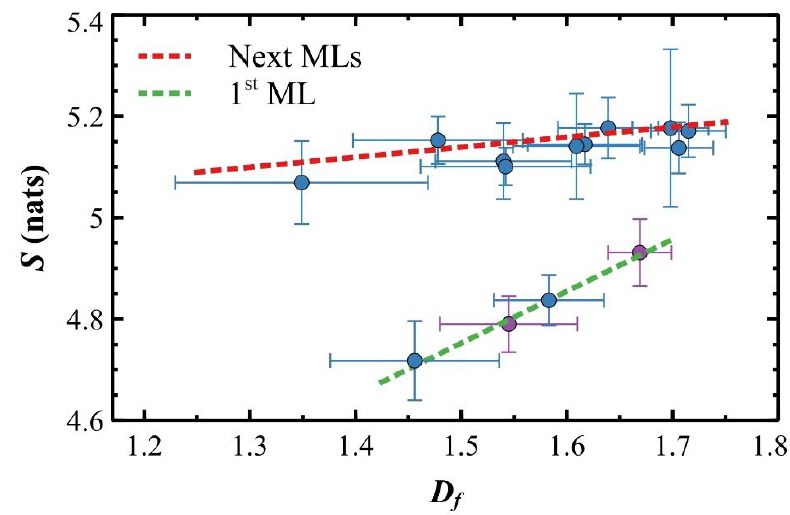
Figure 7. (Averaged) interfacial Shannon entropy S and fractal dimension D f plot with fitted linear correlations. All the data were obtained from the AFM images at 25 °C and 50 °C, averaging the values obtained from all the single islands.